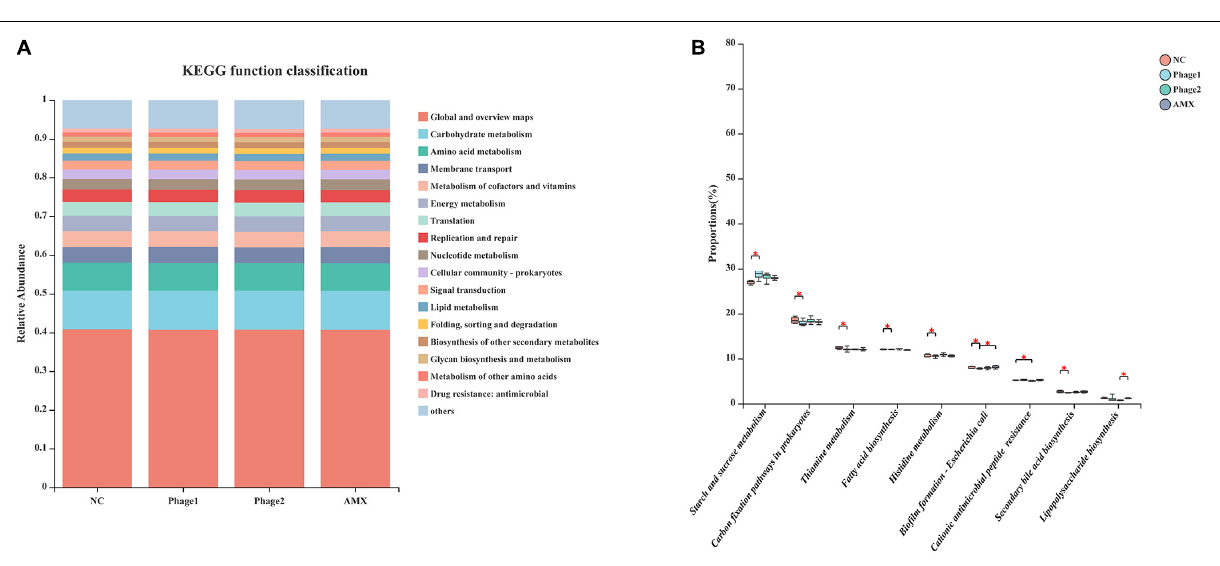
FIGURE 10 | Functional prediction of cecal microbiota (A) KEGG Pathway level 2 function classification; (B) Differential analysis of the KEGG pathway level 3 of cecal microbiota. The Kruskal–Wallis H test was used for differential analysis. NC, negative control; Phage 1, 10 9 PFU GRNsp6 (day 3-5); Phage 2, 10 9 PFU GRNsp6 (day 8-10); AMX, 1 mg/ml amoxicillin (day 8-10). ∗ p <